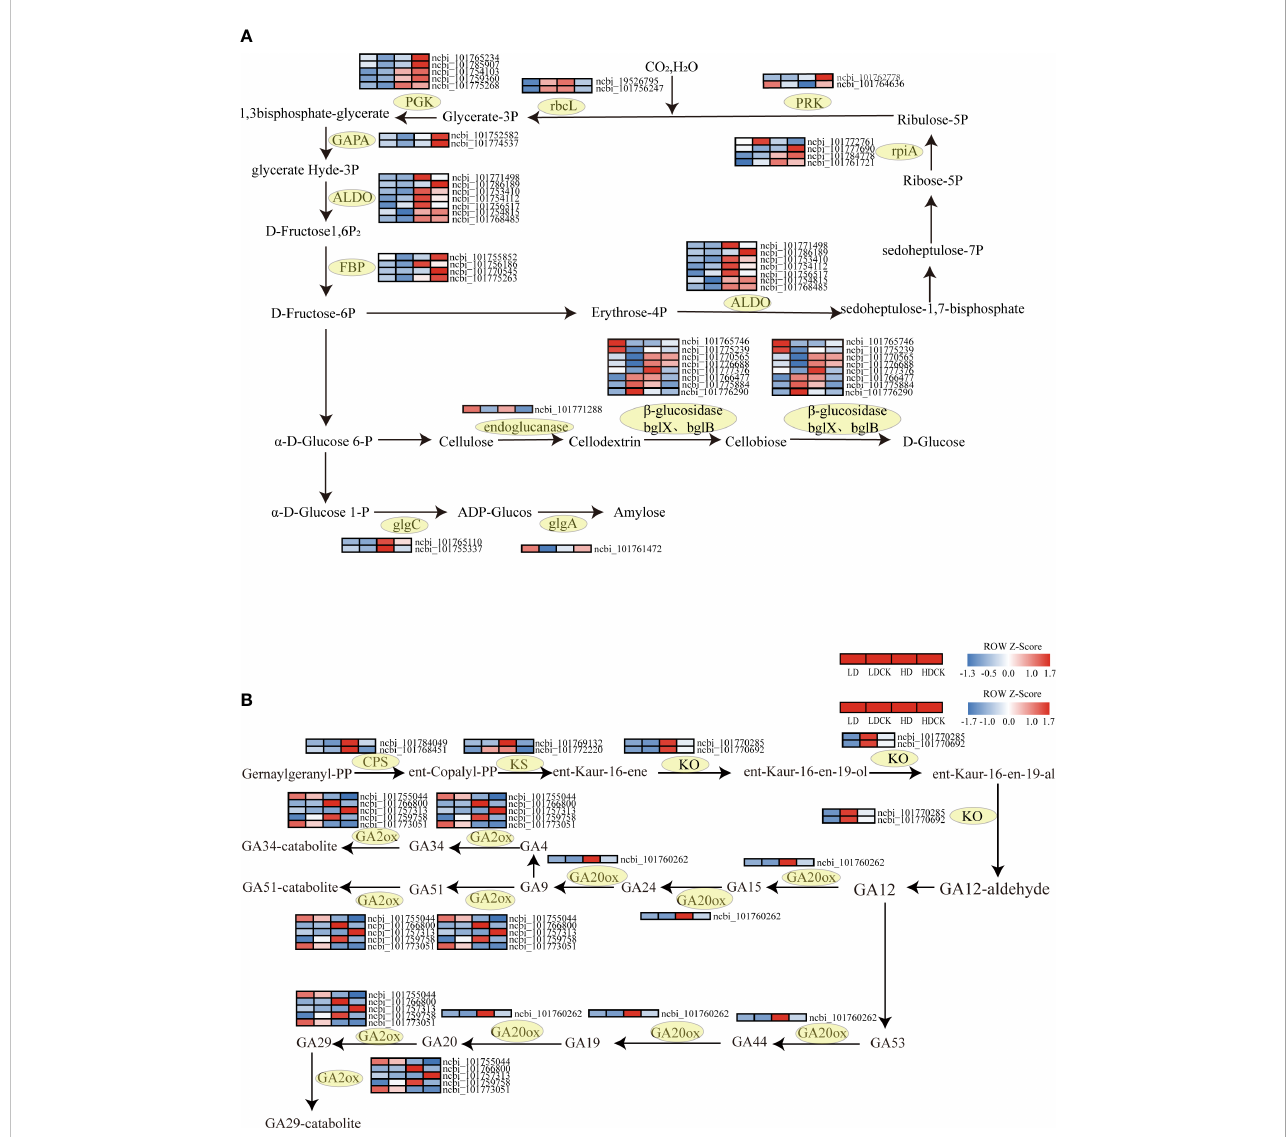
FIGURE 7 Photosynthetic carbon sequestration with sucrose and starch and synthesis, gibberellin synthesis under drought stress gene changes. The color patch represents the FPKM value. Red and blue indicate signi fi cant upward and downward revisions Gene (log 2 |fold-change| ≥ 1). (A) Heat map of drought response DEGs involved in photosynthetic carbon fi xation, sucrose and starch synthesis pathways under drought stress. (B) Heat map of drought- responsive DEGs involved in gibberellin synthetic pathways under drought